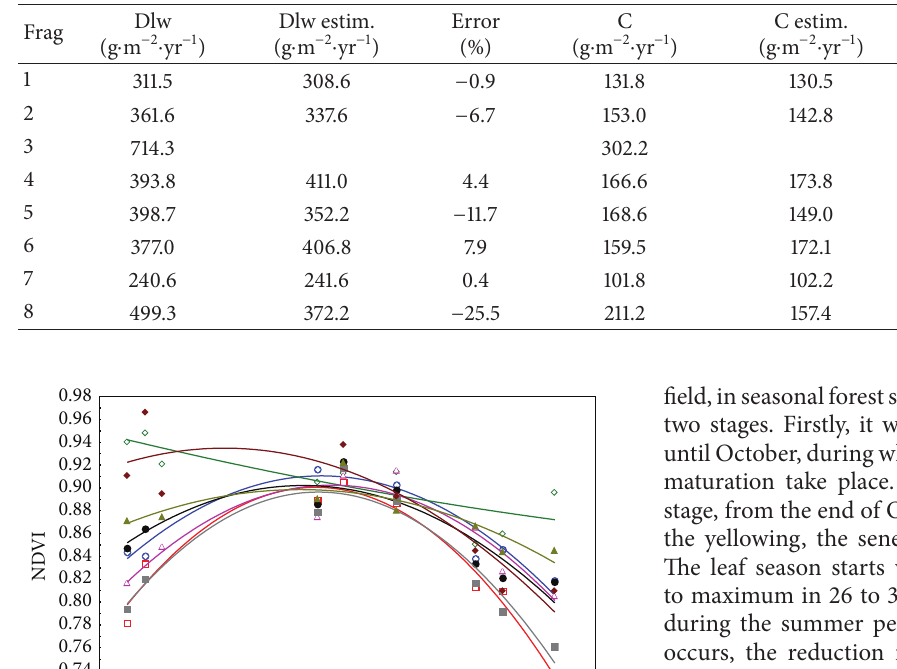
Table 6: Observed and estimated data of dry leaf weight (Dlw), error of estimation (%), and fixed carbon in the leaves (C) considering 42.3% ofthebiomass(average valueofcontents inleaves offorestspecies isobtained by Watzlawick etal., 2011[31]),captured CO (44 g), with the observed data and that estimated by the model. of atomic weight between C (12g) and CO 2